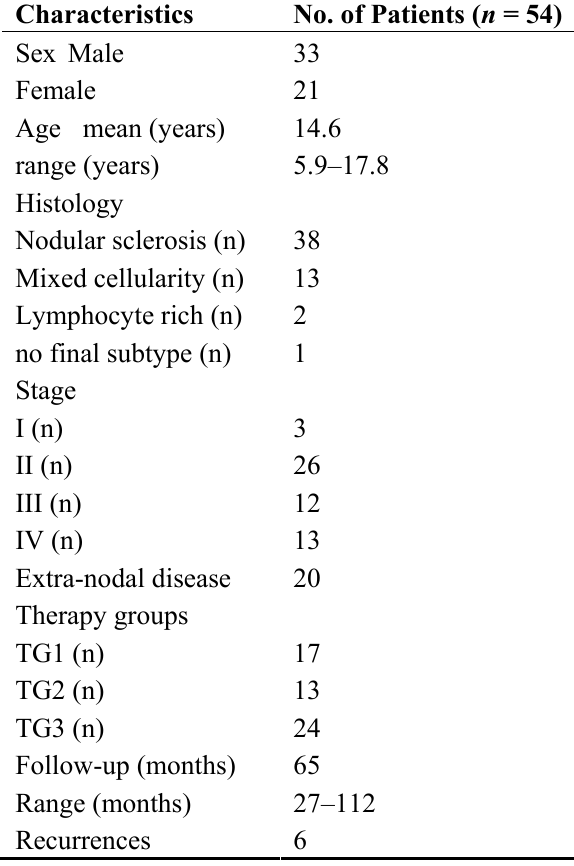
Table 1. Patients